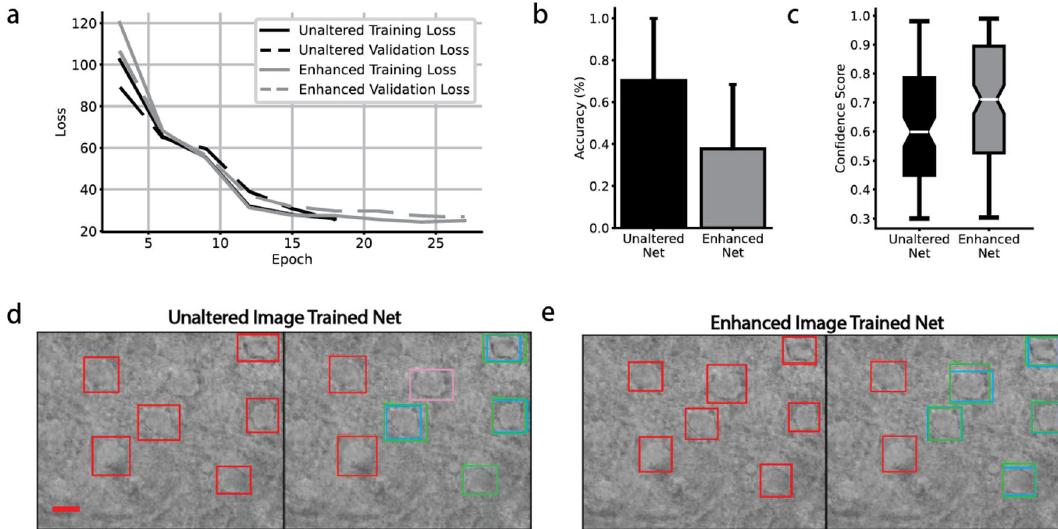
lines represent training loss, and dashed lines represent validation loss. ( b ) The bar chart shows mean ± SD comparison of the average accuracy between the unaltered net and enhanced net on the unaltered data